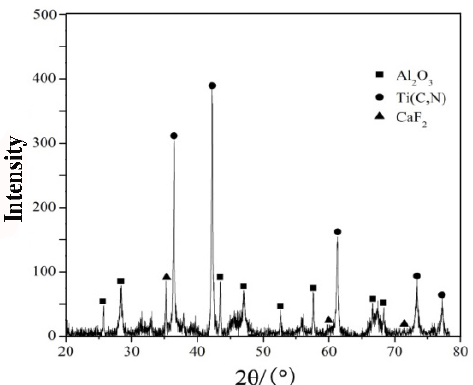
Figure2. X-raydiffraction(XRD)patternoftheATCN-C@10ceramictoolwith10vol.%CaF 2 @Al 2 O 3 added . Figure 2. X-ray diffraction (XRD) pattern of the ATCN-C@10 ceramic tool with 10 vol.% CaF 2 @Al 2 O 3 added .